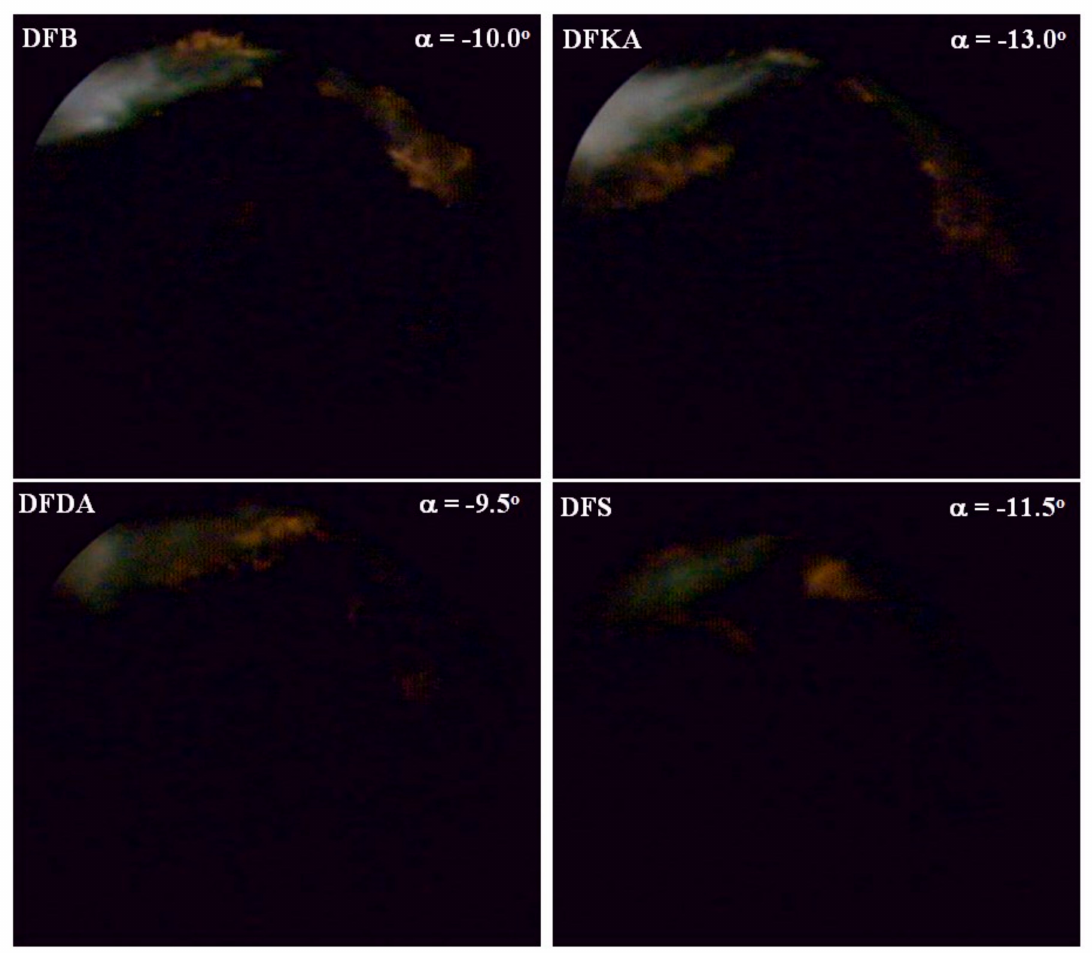
Figure 27. Image from inside engine cylinder for crankshaft angle of rotation corresponding to the beginning of fuel self-ignition α SC in combustion of tested